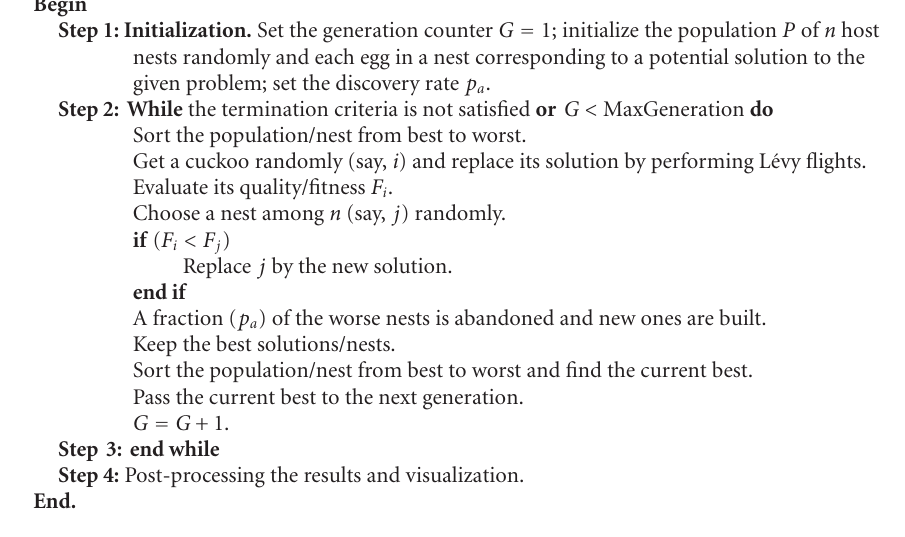
Algorithm 2: The algorithm of cuckoo search (CS) via L´evy